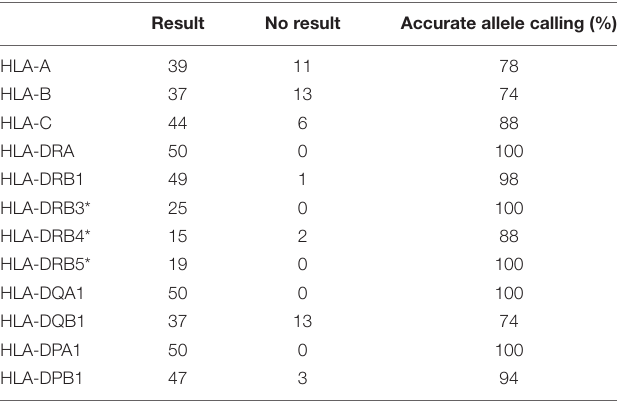
TABLE 1 | HLA genotyping results from ONT RNA-Seq and allele calling rate.